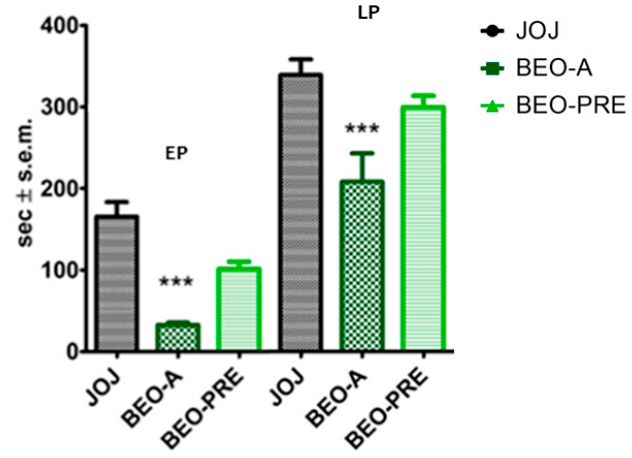
Figure 2. Analgesic effect of the transdermal administration of the essential oil of bergamot (BEO) on licking/biting behavior in the formalin test. The essential oil of bergamot (BEO) reduced licking/biting behavior when administered immediately after formalin injection in the early and in the late phase of formalin test (BEO-A). This effect did not persist after the 5 min pretreatment followed by washout (BEO-PRE). Overall licking/biting time is expressed as time in s ± SEM during the early phase (EP) (0–10 min) and the late phase (LP) (10–30 min). One-way ANOVA followed by Bonferroni test; n = 8; *** p < 0.001.